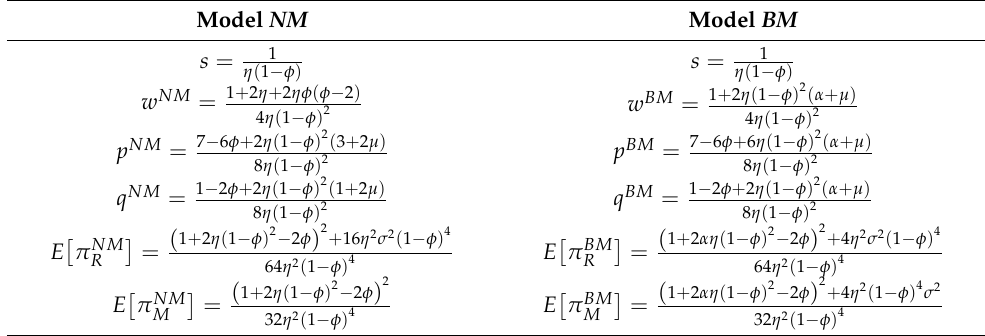
Table 5. Outcomes in Model iM ( i = N , B )